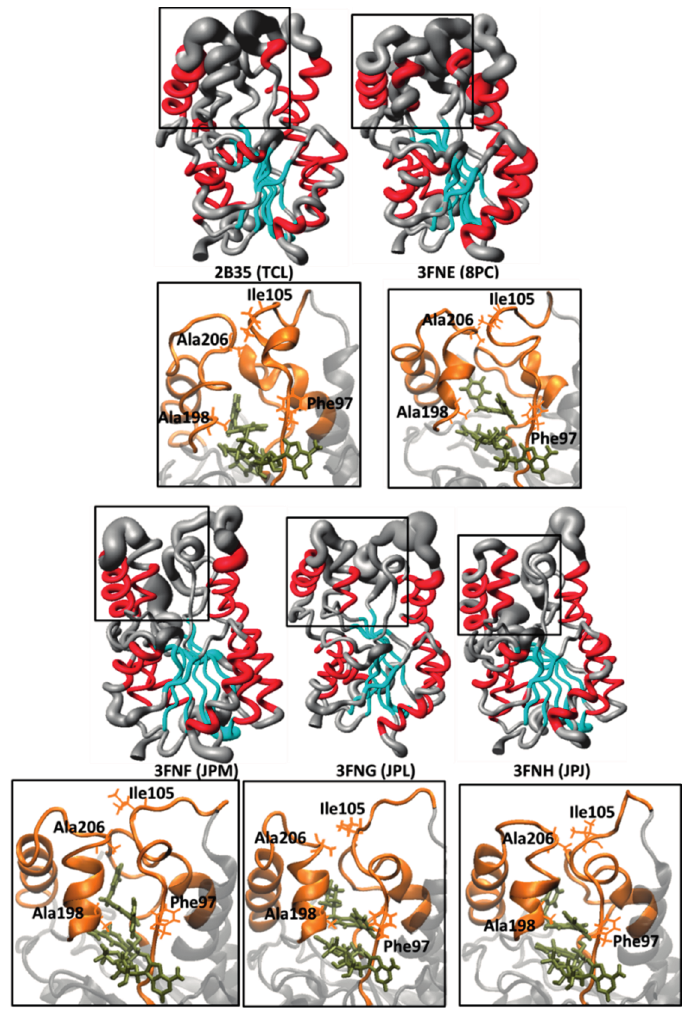
Figure 7. Spatial RMSD (RMSF) of InhA-NADH (protein secondary structure color code: α -helix, red; β -sheet, cyan; loop, grey) in complex with triclosan (TCL) and its derivatives (8PC, JPM, JPL, and JPJ) during the MD simulations and the corresponding close view of the substrate binding pocket, showing the Phe97 (LLP-4), Ile105 (MLP-4), Ala198 (AH-6), and Ala206 (LP-6) residues used for measure the LP-6/MLP-4 and AH-6/LLP-4 distances to characterize the protein open and closed